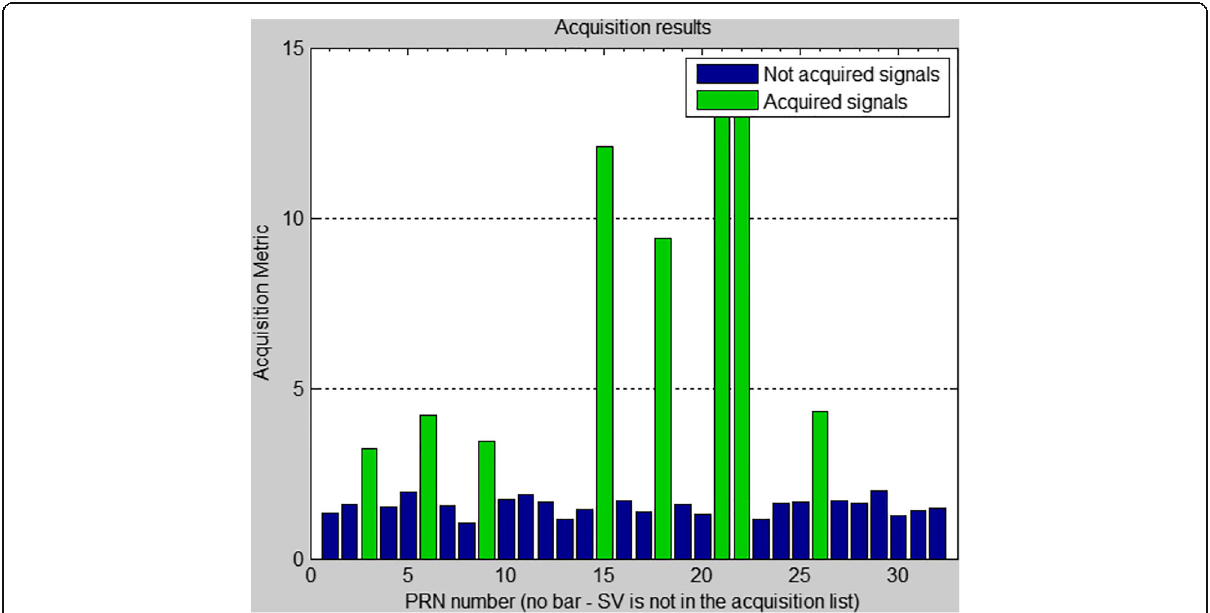
Fig. 7 The proportional peak diagram of satellite acquisition. This is an intuitive display of the results of the capture of 32 GPS satellites in the test. In the figure, the green bars represent successful acquisition and the blue bars represent a capture that failed